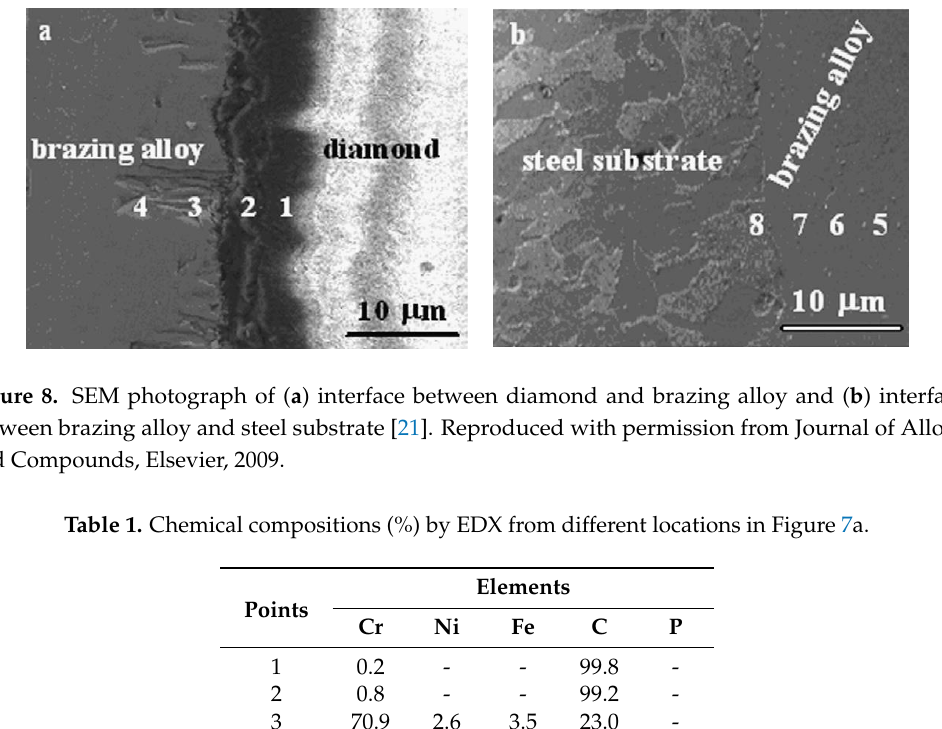
Table 2. Chemical compositions (%) by EDX from different locations in Figure 7b. Points